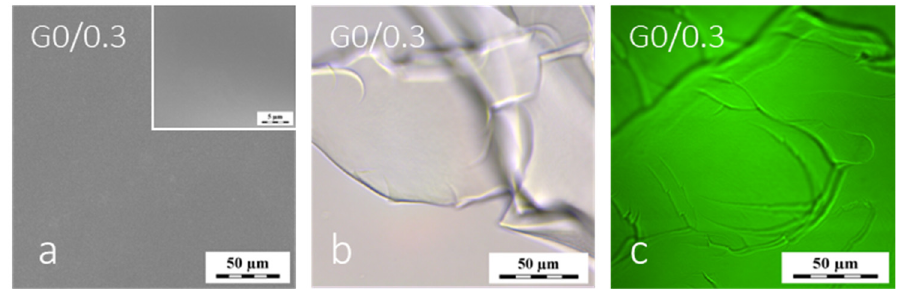
Figure 2. Morphology of the G0/0.3 hydrogel swollen in water observed by methods: ( a ) environmental scanning SEM (ESEM), ( b ) light microscopy (LM) and ( c ) laser scanning confocal microscopy (LSCM).